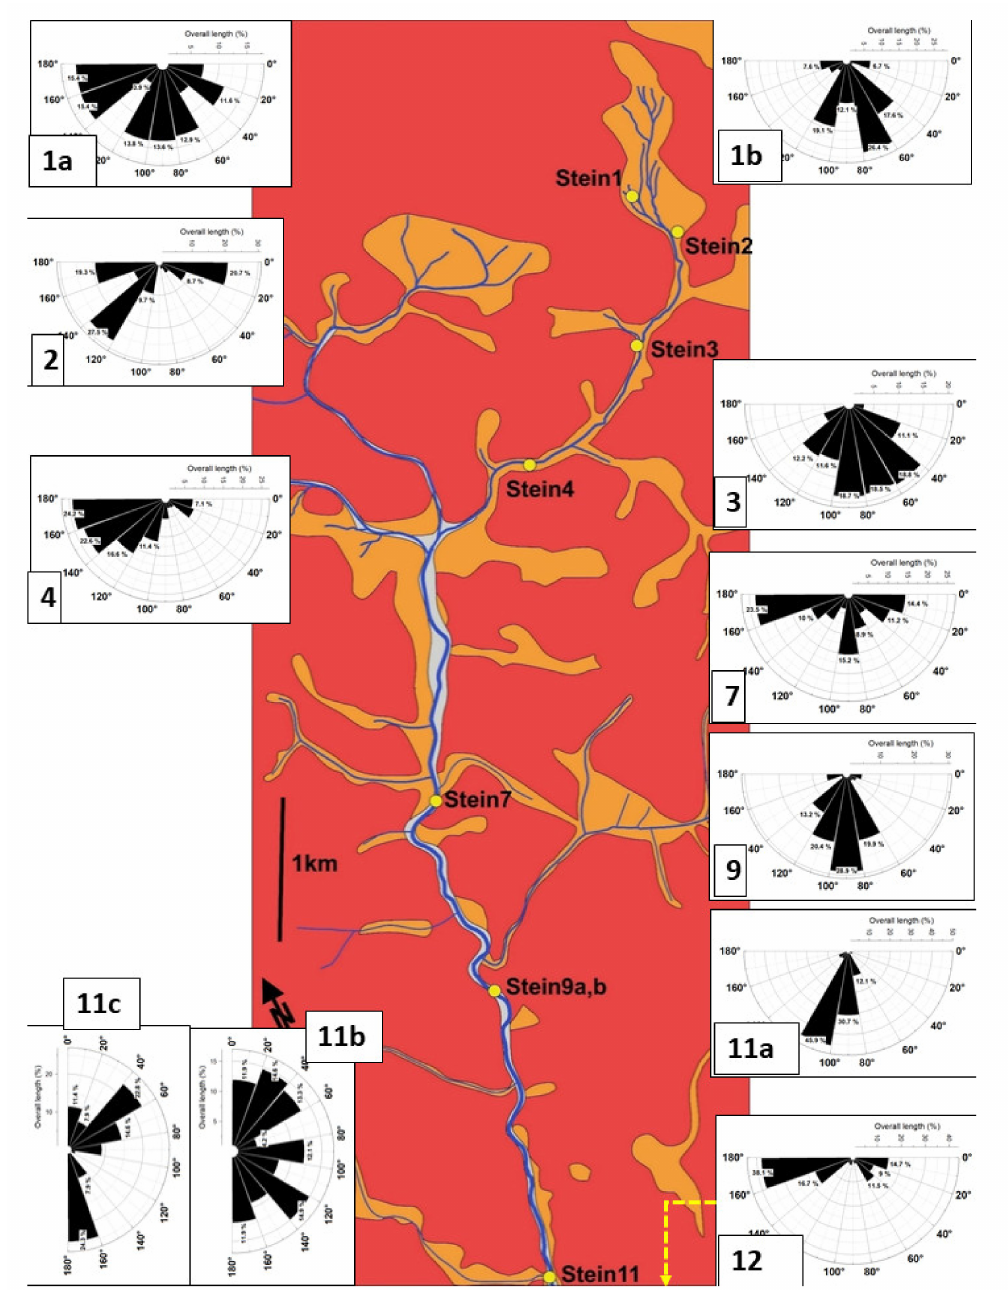
Figure 14. Situmetric measurements (orientation of the longest axis of gravel) along the Steinach River from the source to the point of entrance into the foreland of the Weidenberg Sediment Bowl. All rose diagrams are oriented perpendicular to the fluvial gradient. See also (Table 3a) for more detail. The subfigures (diagrams) and their numbers are referred to in the